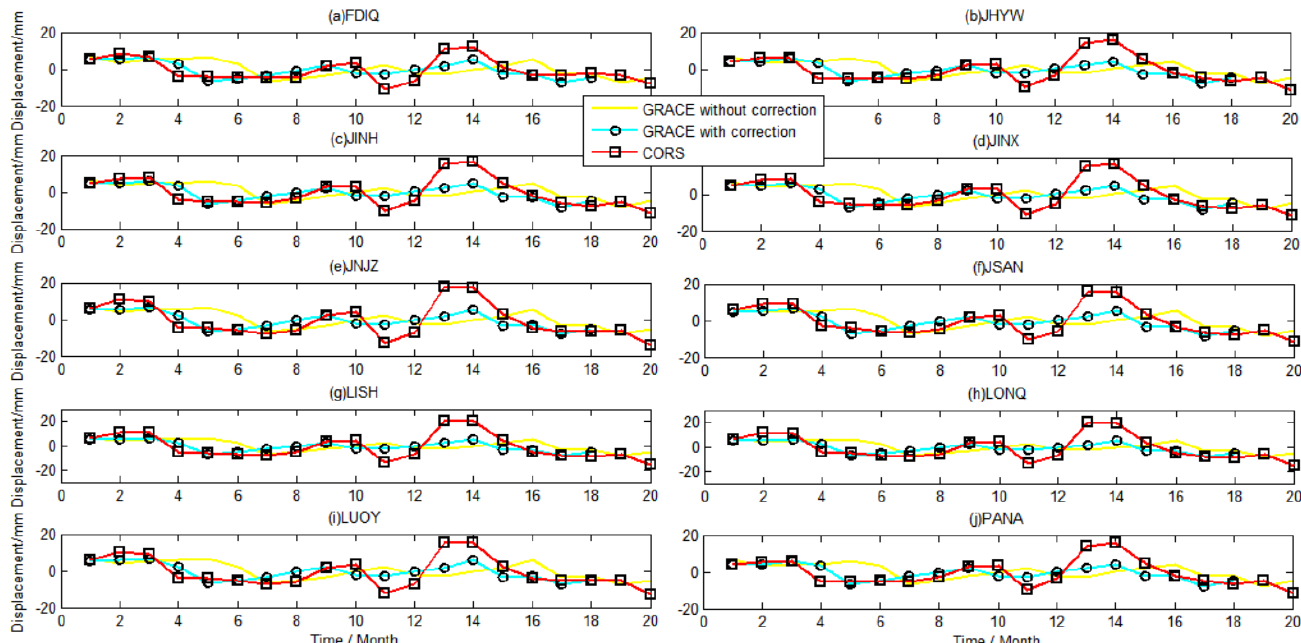
Figure 9. Comparison of the effects of terrestrial water load derived from the CORS network and GRACE.